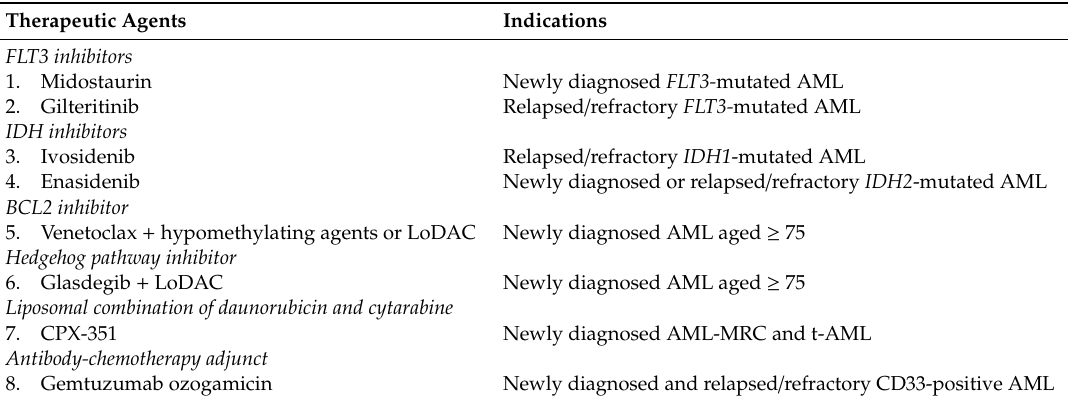
Table 1. Eight FDA-approved therapeutic agents in acute myeloid leukaemia